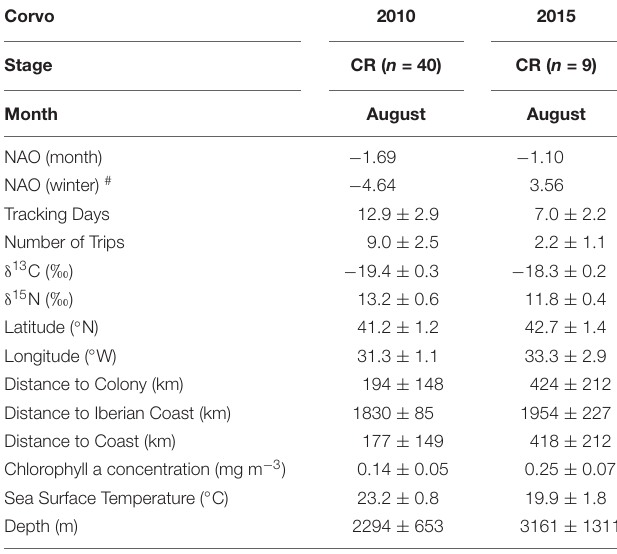
TABLE 3 | Predictor variables for the oceanic environment and plasma δ 13 C and δ 15 N values of Cory’s shearwaters ( Calonectris borealis ) breeding in Corvo Island during the chick-rearing (CR) period in 2010 and